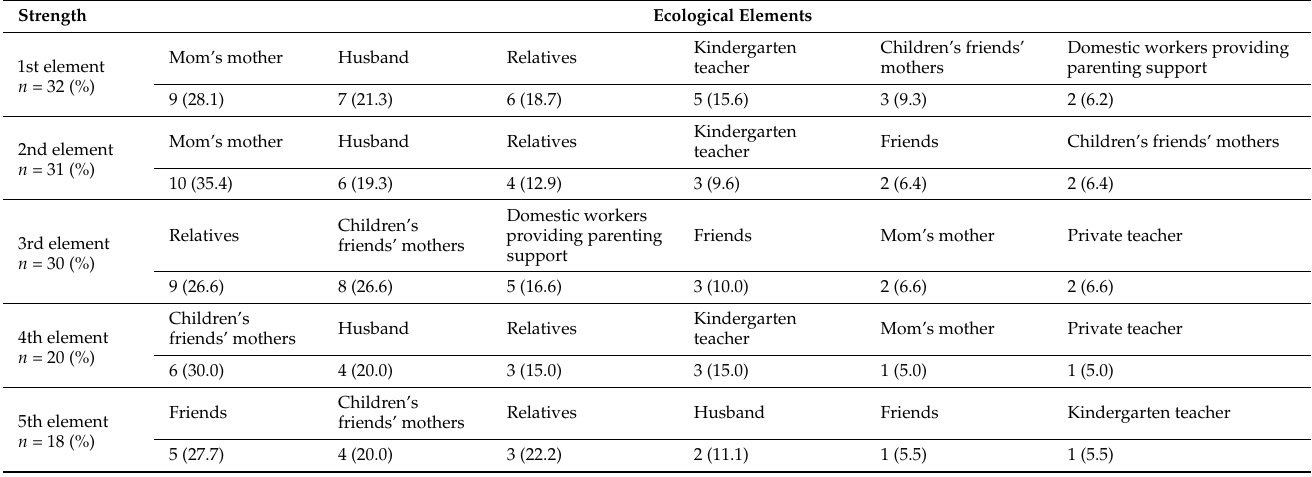
Table 3. Strength of the ecological